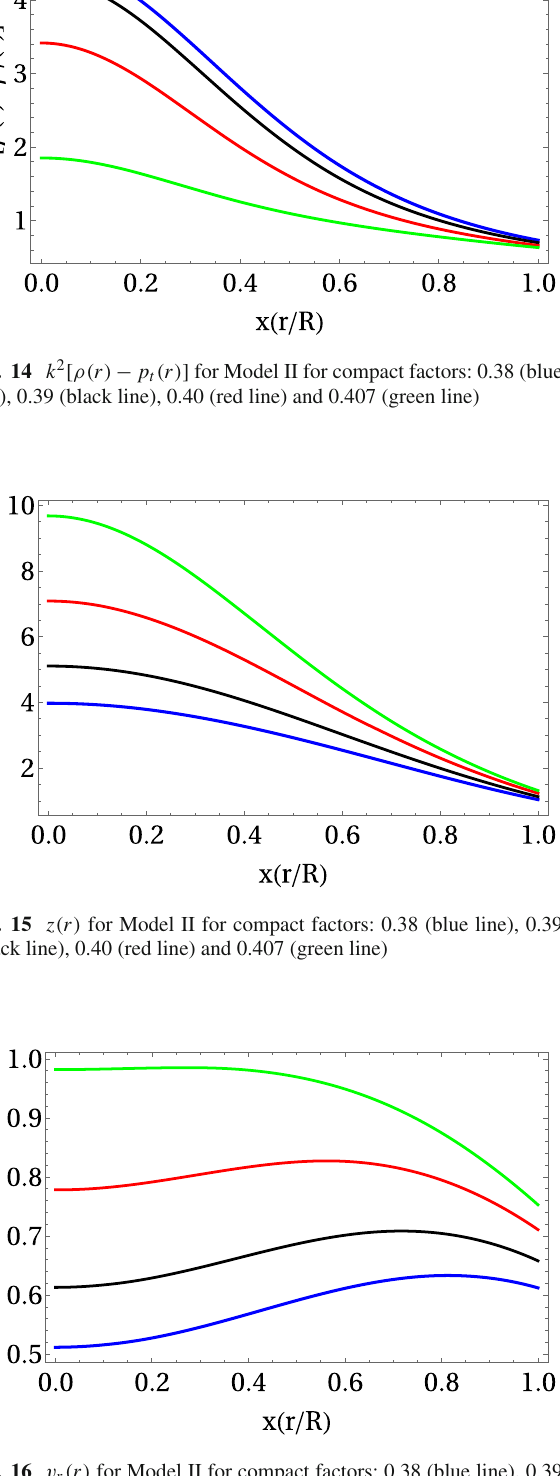
Fig. 16 v r ( r ) for Model II for compact factors: 0.38 (blue line), 0.39 (black line), 0.40 (red line) and 0.407 (green line)